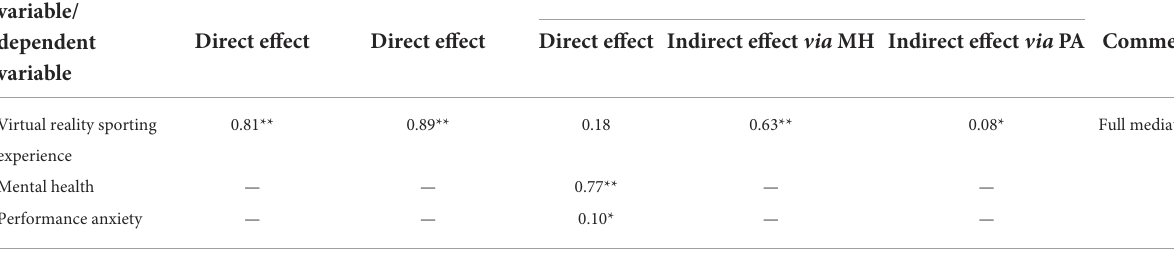
TABLE 9 Direct and indirect